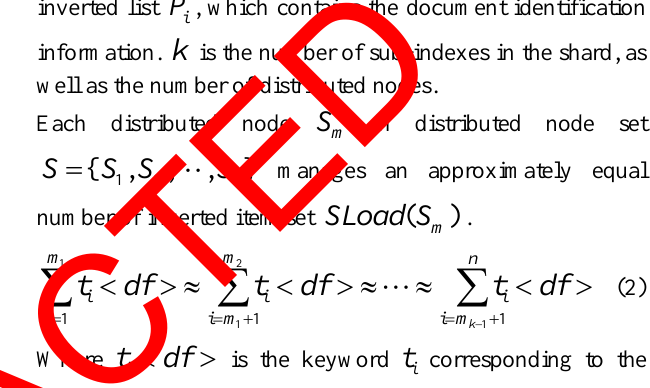
Algorithm 2 . Ciphertext index segmentation